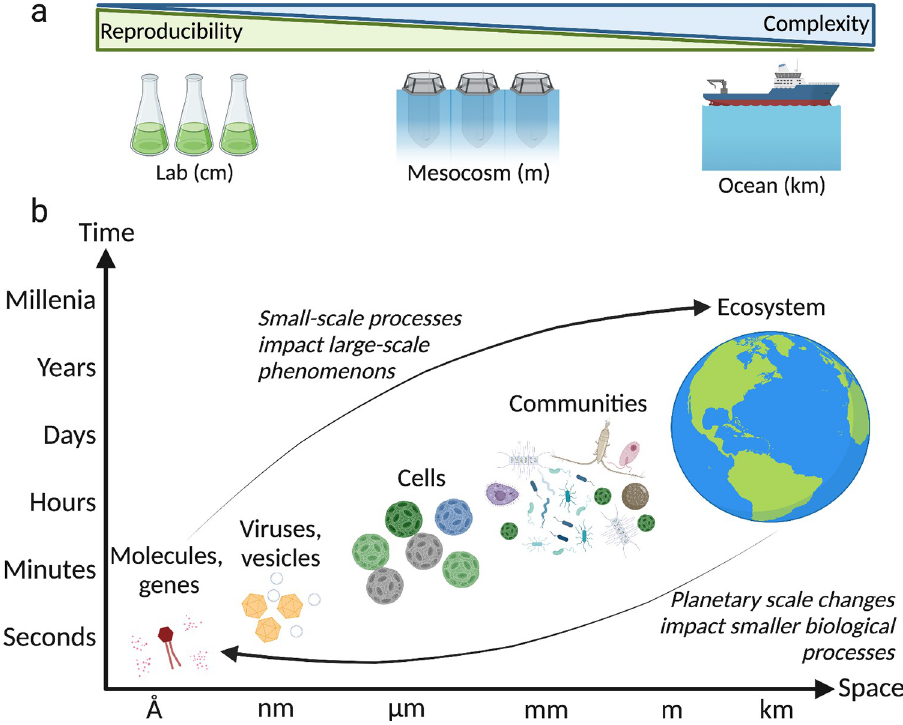
Fig 3. Viral infection in the ocean—A journey across scales. (a) The large range of spatiotemporal levels at which viral infection leaves an ecological imprint requires different scales of experimental setups, each one representing a trade-off of reproducibility versus complexity. Laboratory experiments guarantee reproduciblity but often compromise on the biological complexity, while open ocean studies embrace full natural entanglement to a level that is hardly reproducible. Mesocosm experiments represent a valuable intermediate step, by observing the natural environment under semicontrolled conditions. ( b) Viral infection can be viewed by observing different biological units, from metabolites to ecosystems, each corresponding to a range of temporal and spatial scales. Both small and large levels of biological organisation influence each other. Created with BioRender.com.